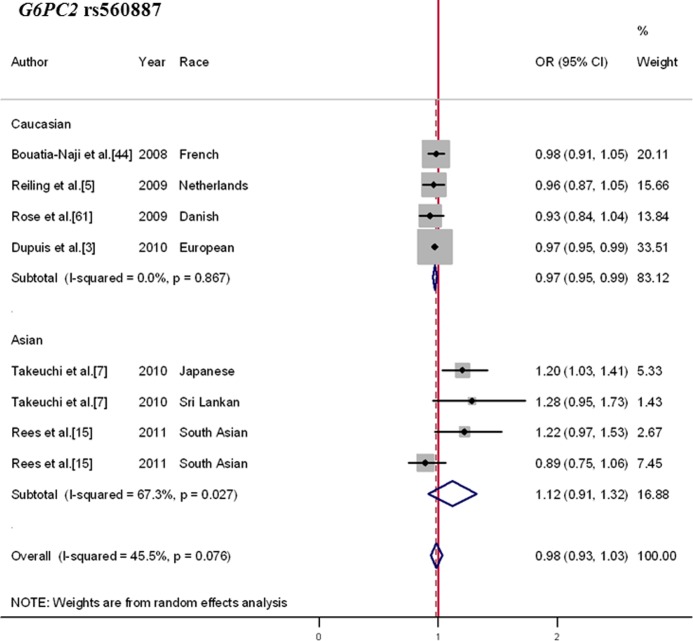
Forest plot for the association between G6PC2 rs560887 and T2DM.Pooled OR for the additive genetic model was shown under a random-effects model. Square sizes were proportional to weight of each study in the meta-analysis. Contrasting results were detected between Caucasians and Asians.